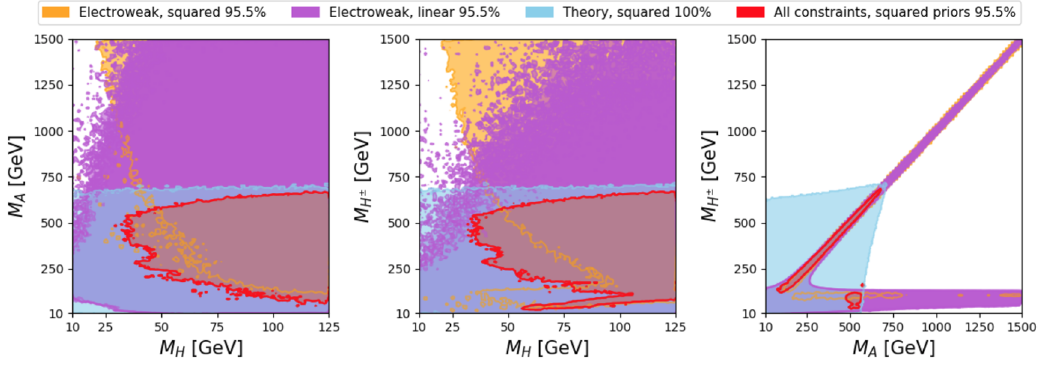
Figure 10. Two-dimensional constraints on the mixing angle ˜ α and the Yukawa couplings y h from a global fit with the “wrong-sign” solution for the Higgs signal strengths. The plots show the allowed regions at 99.7% (brown), 95.5% (orange) and 68% (yellow) probability.